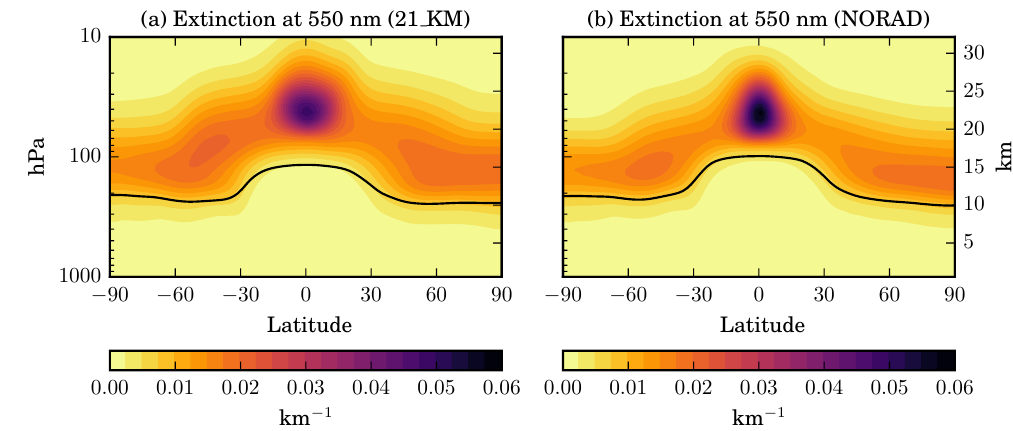
Figure 14. Latitude–height cross section of the zonal and annual mean distribution of the aerosol extinction coefficient (km − 1 ) at 550nm for equatorial stratospheric sulfur injections at 21km from (a) a simulation with radiatively interactive aerosol (21_KM) and (b) a simulation with non-radiatively interactive aerosol